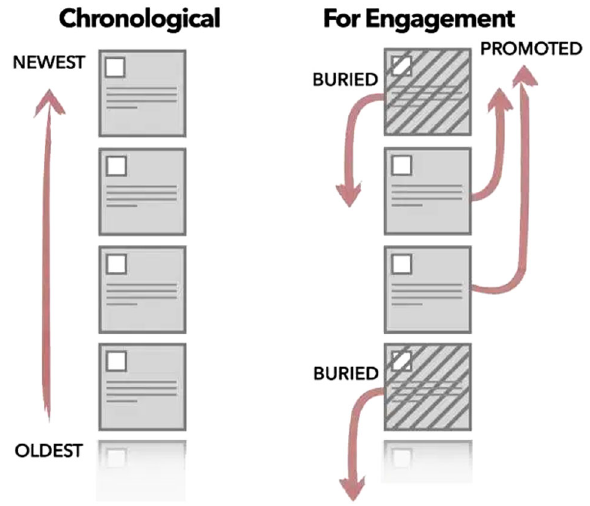
Fig. 3 Content Prioritization. Diagram from Rose-Stockwell showing the change in content prioritization (reproduced with